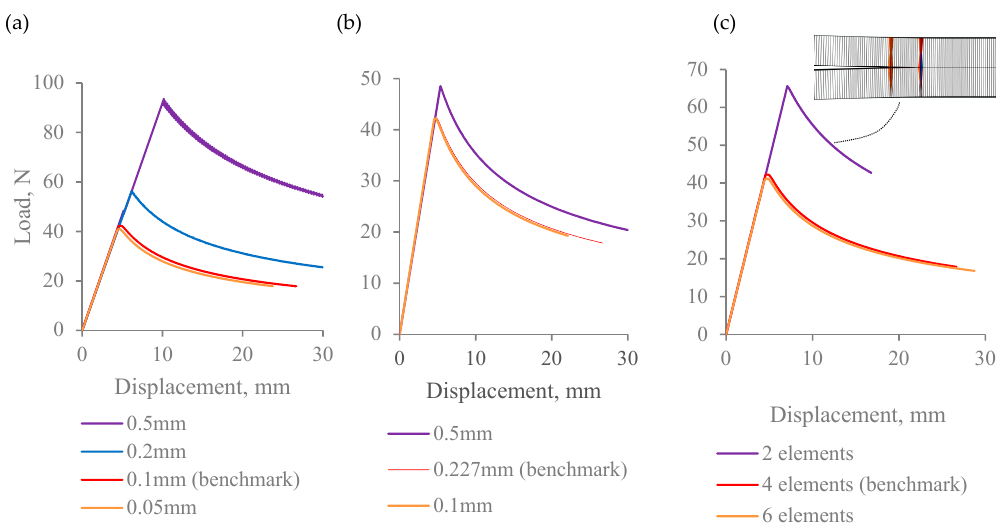
Figure 7. The load-displacement curves for Mode I loading when mesh density varies ( a ) along the